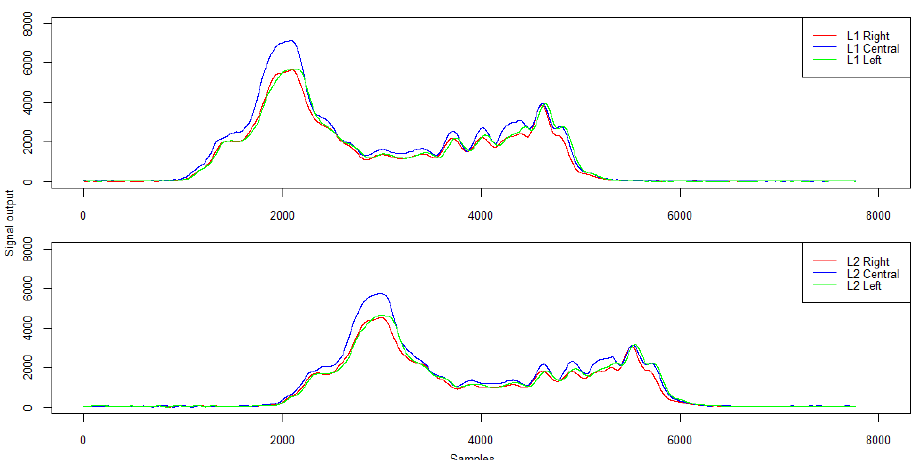
Figure 17. Example signals from induction loops for right- and left-hand passing and in lane alignment—five-axle vehicle. Table 7. Signal characteristics from inductive loops—amplitude and mean signal level (ADU).